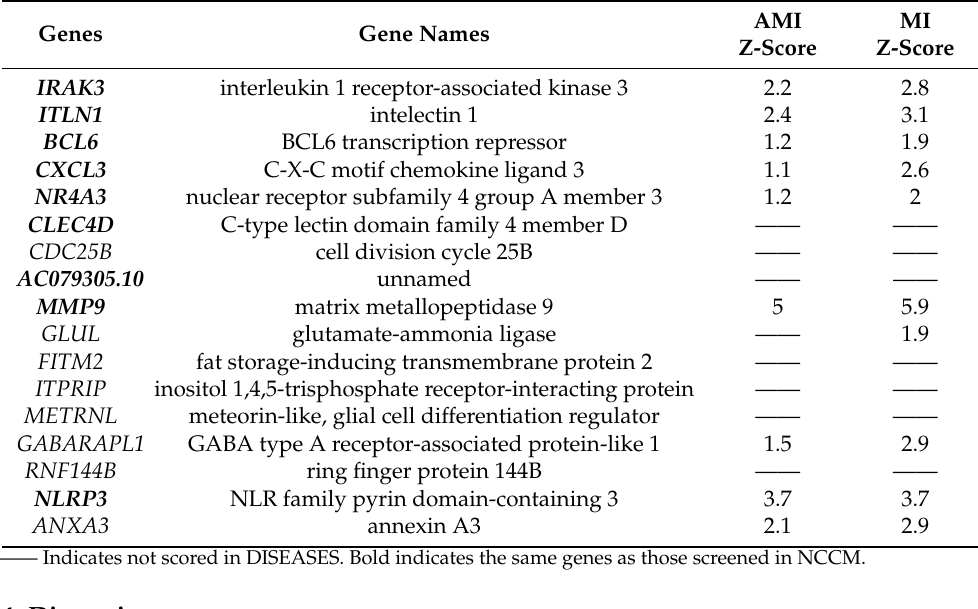
Table 3. Category of